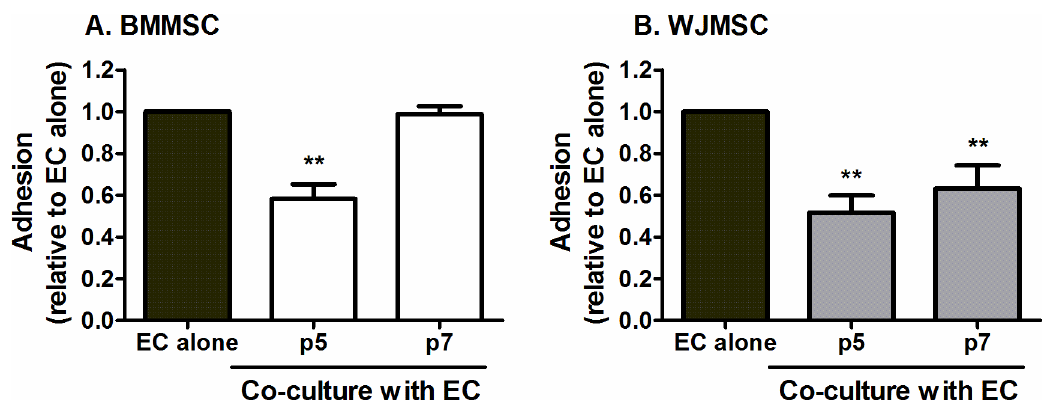
Fig 4. Effects of passage on the ability of MSC to suppress neutrophil recruitment. (A) BMMSC or (B) WJMSC at different passage number were co-cultured with EC on opposite sides of a porous filter for 24h prior to stimulation with TNF α for 4h. Neutrophil adhesion was expressed as a proportion of that observed on the paired EC mono-culture control. In A and B, ANOVA showed a significant effect of passage on neutrophil adhesion, p < 0.01. Data are mean ± SEM from (A) n = 13 for EC, n = 13 p5 MSC-EC and n = 3 p7 MSC-EC co-cultures and (B) n = 3 for all data independent experiments using a different EC and neutrophil donor in each experiment. (A) 5 or 3 different BMMSC donors were used at p5 or p7 respectively; and (B) 3 different WJMSC donors were used at both passages. ** = p < 0.01 compared to EC mono-cultures by Dunnett